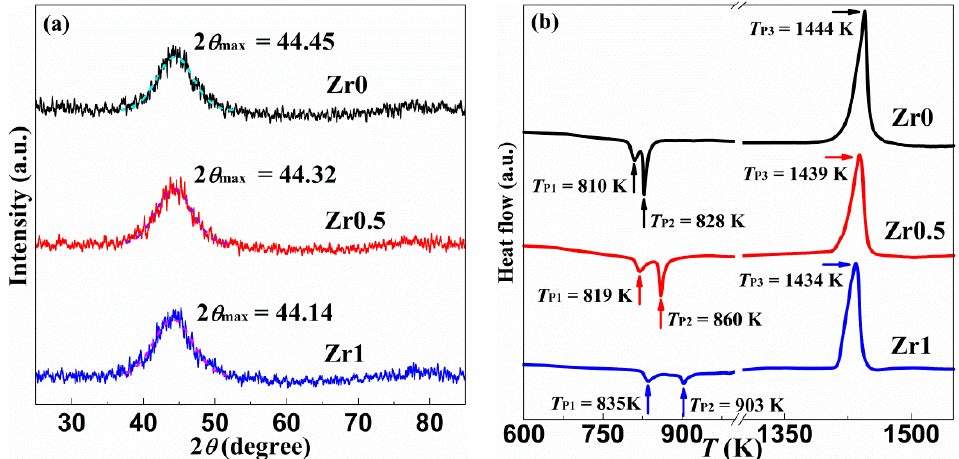
Figure 1. ( a ) The X-ray diffraction (XRD) curves of as-spun Zr0, Zr0.5 and Zr1 ribbons, ( b ) the differential scanning calorimetry (DSC) curves of the as-spun Zr0, Zr0.5 and Zr1 ribbons.